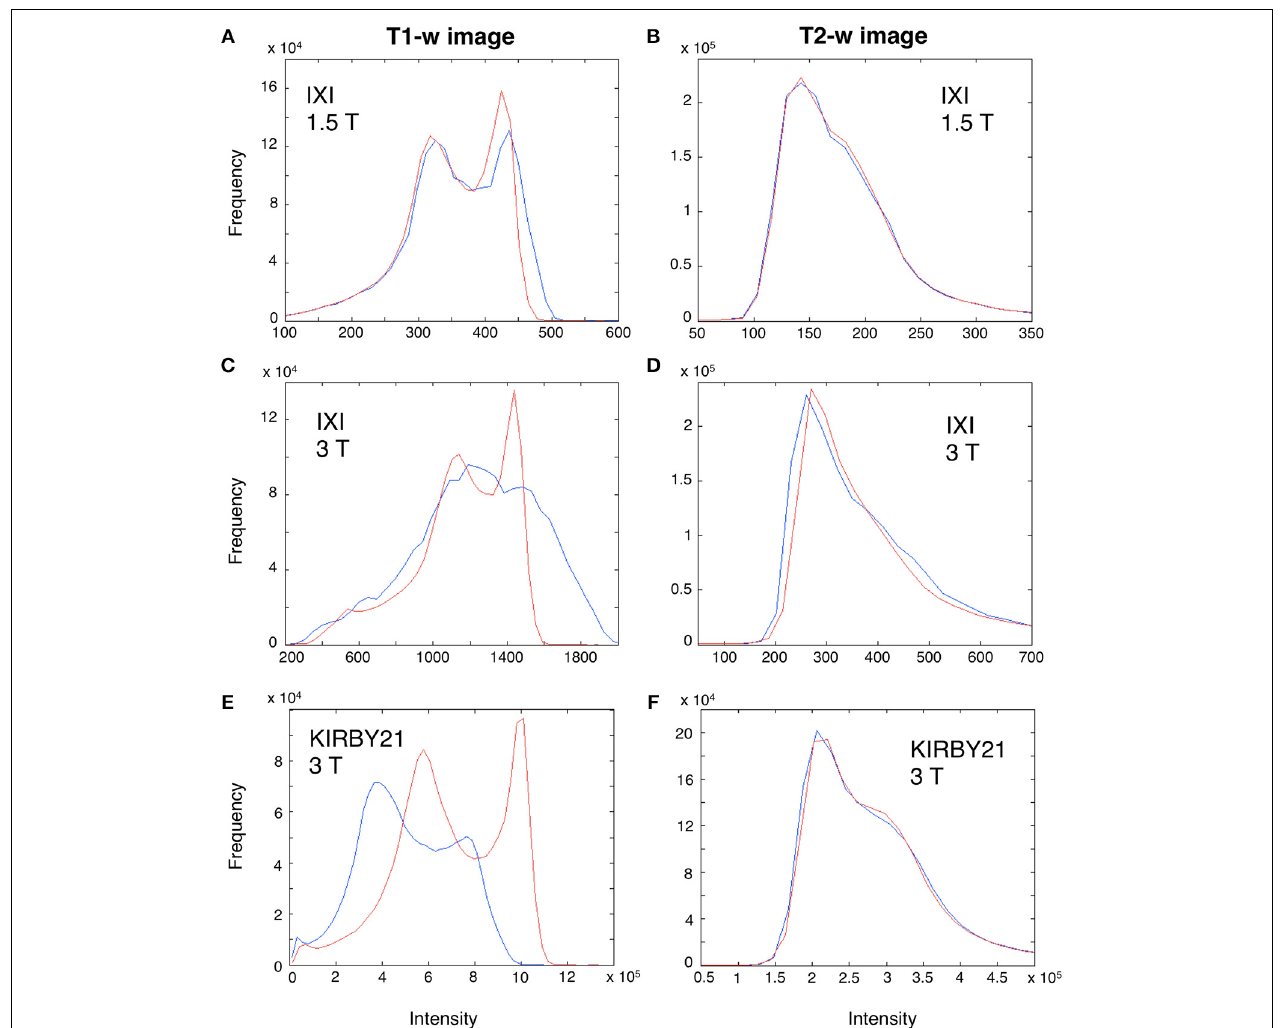
FIGURE 6 | Effect of bias correction on T1-w and T2-w images. A modality-dependent bias correction procedure was performed for both T1-w and T2-w. To illustrate the relative results, we analyzed the T1-w (A,C,E) and T2-w histogram (B,D,F) of three representative subjects from the IXI 1.5 T (Subject 002), IXI 3 T (Subject 093) and KIRBY21 (Subject 30) databases, respectively. Specifically, we compared the histograms before (blue line) and